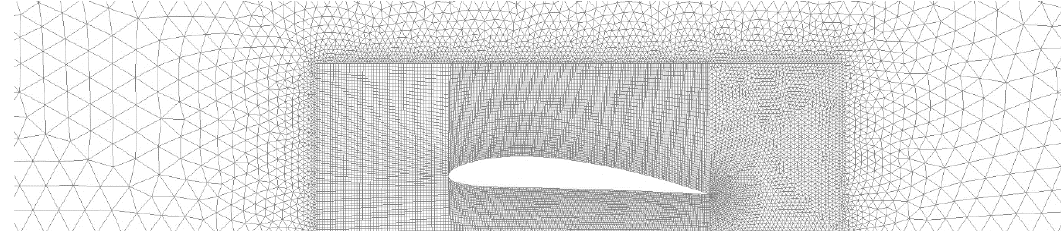
Figure 2. Detailed view of the mesh around a section of the compound wing.